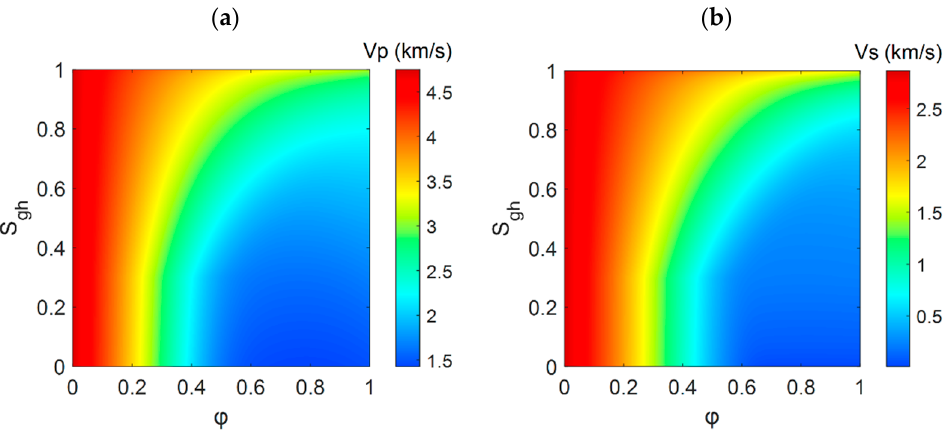
Figure 6. Contour plots of P- and S-wave velocities varying with S gh and ϕ for S c = 0.3: ( a ) V P , ( b ) V s.